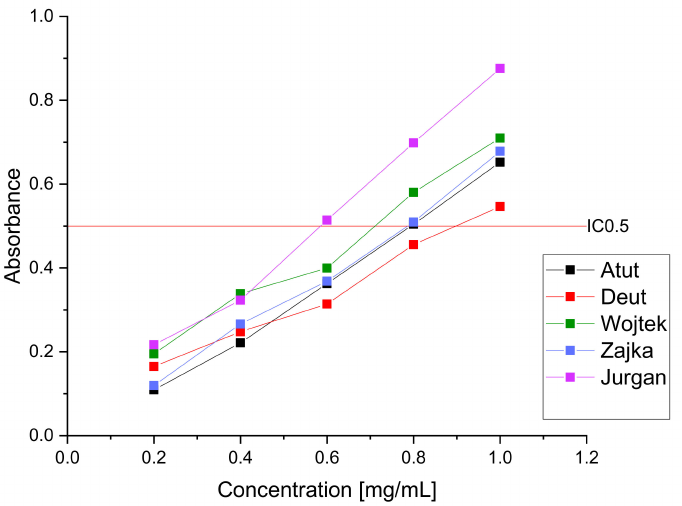
Figure 5. Antioxidative activity of aqueous water extracts of haskap berry leaves in FRAP